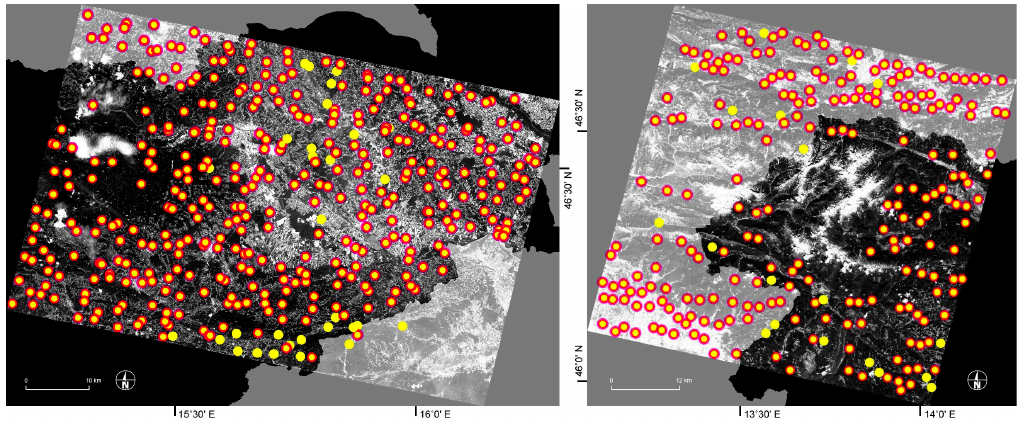
Figure 8. Examples of GCP distribution on two RapidEye images: lowland ( left ) and mountainous area ( right ). The area of Slovenia is presented in black. The GCPs that were used by the physical sensor model are outlined in red, while the eliminated ones are not outlined. The lack of GCPs noticeable in some neighbouring countries (lower right corner of the left image) is a result of the use of an insufficiently reliable reference road data source for this area ( i.e. , OpenStreetMap). Another noticeable lack of GCPs can be seen in the mountains (centre of the right image), which is an inherent drawback of the proposed method, since it is based on the presence of roads.